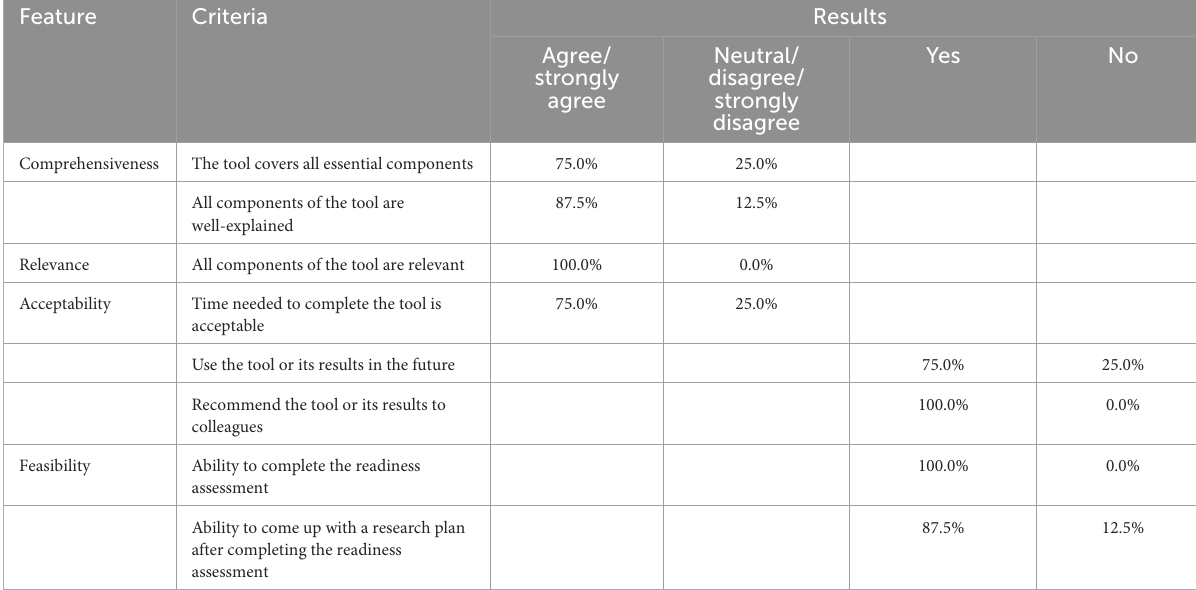
TABLE 3 The post-pilot assessment